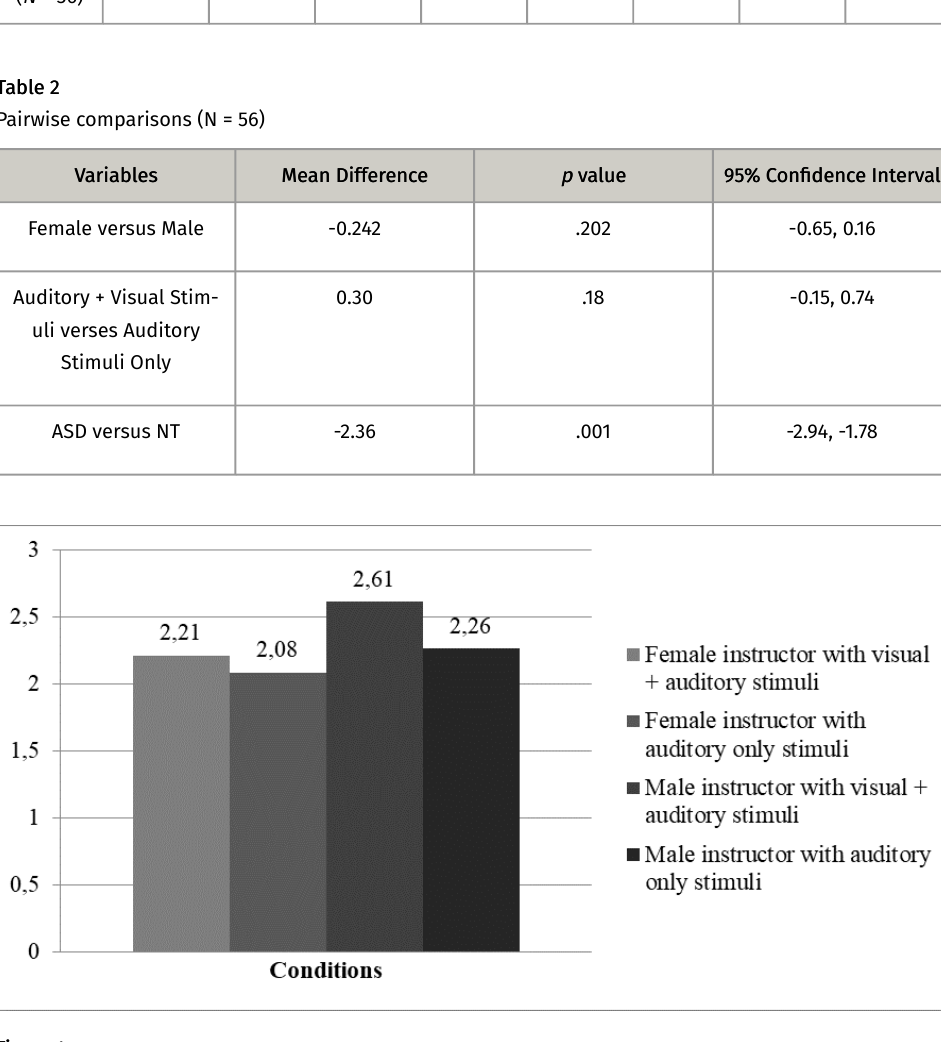
Mean # of Correct Responses by Condition for Individuals with